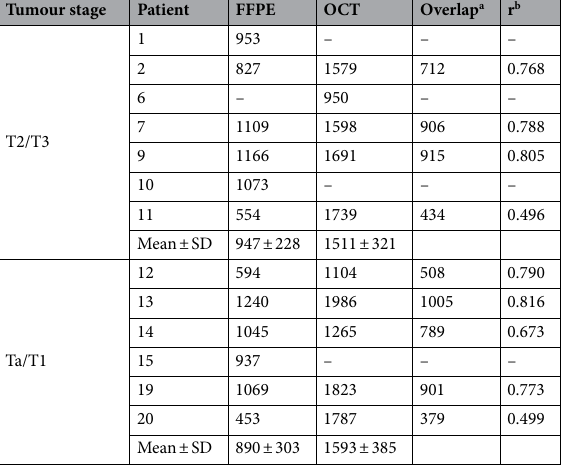
Table 1. Number of quantifiable proteins in tumour samples from different patients preserved using different methods. a Number of proteins commonly quantified in tumours preserved by different approaches. b The correlations of quantitative measured values, the normalized LFQ intensities, from FFPE and OCT samples, presented by Pearson’s correlation coefficients